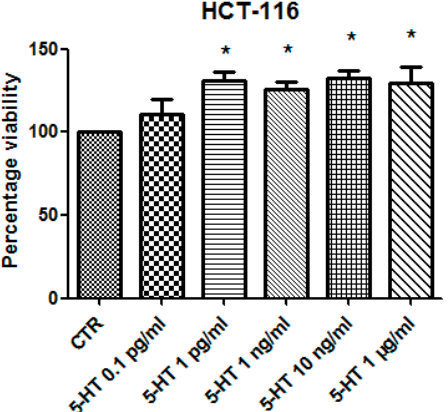
Figure 1. Effects of serotonin (5-HT) on colon cancer HCT116 cell viability (MTT test). Data are means ± SD and analyzed through analysis of variance (ANOVA), followed by post hoc Newman–Keuls test. ANOVA, p < 0.01; post hoc , * p < 0.05 vs. CTR (control) group.